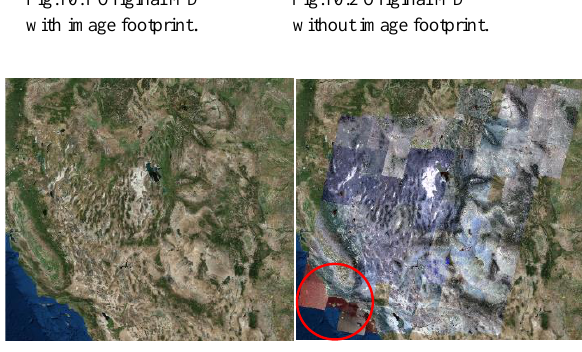
Fig.11.1 World_Imagery used Fig.11.2 Original MD as external target image. superimposed on the external target image.